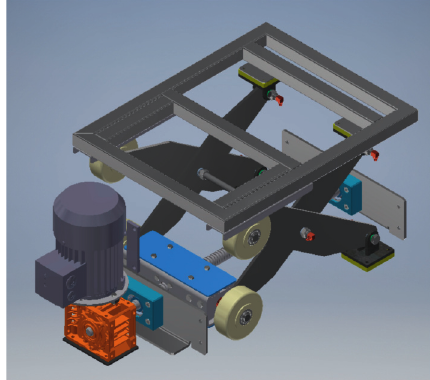
Figure 8: Transport platform.